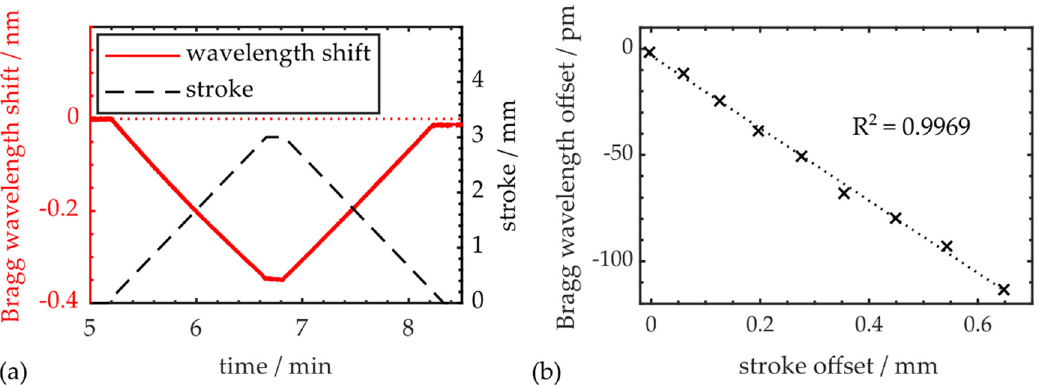
Figure 7. ( a ) Time trace of workpiece deflection and sensor response during three-point bending, revealing a wavelength offset at the end of the cycle; ( b ) Bragg signal offset due to plastic deformation induced by maximum strokes up to 6 mm.